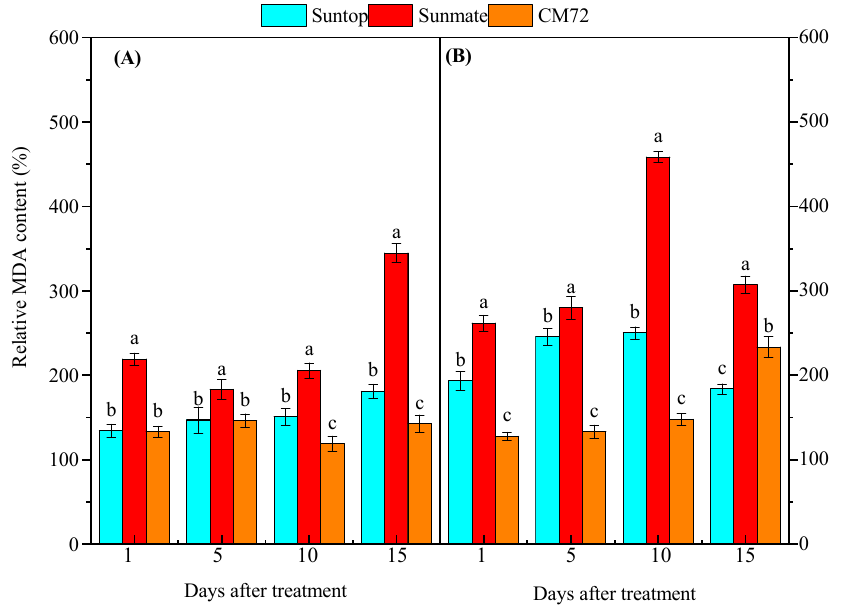
Figure 4. Effect of salinity stress on malondialdehyde contents (MDA, nmol -1 FW) in leaves ( A ) and roots ( B ) of Suntop (Aqua), Sunmate (Red), and CM72 (Orange) 1, 5, 10, and 15 days after treatment with 100 mM NaCl. The data are expressed as a percentage of control content. Different letters indicate signi fi cant differences ( p ≤ 0.05) among the 3 cultivars within each sampling day. Error bars represent SE ( n = 4).